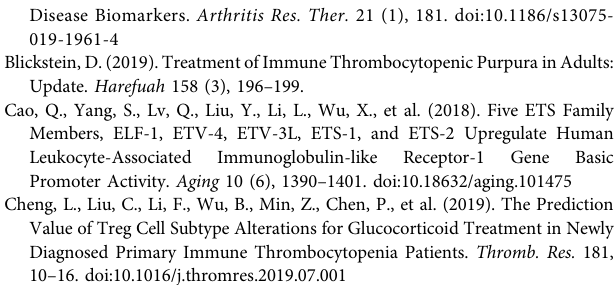
Supplementary Figure 1 | In fl uence of HUWE1 on Treg cell immunosuppressive function. CD4 + T cells in peripheral blood from ITP patients were transfected with HUWE1shRNAfor96 h;CD4 + Tcellsinperipheralbloodfromhealthycontrolswere transfected with Lenti-HUWE1 for 96 h (A,B) The CTLA-4 and LAG3 expressions were assessed using qRT-PCR (mean ± SEM, n (cid:2) 3). ** p < 0.01 vs. shRNA or Lenti. The experiment was repeated three times. Supplementary Figure 2 | Effect of BI8622 on the ubiquitination degradation of Ets-1 by HUWE1. Ubiquitin assay was performed to analyze the ubiquitination of Ets-1 afterthe BI8622 treatment. Theexperiment wasrepeatedthreetimes.DMSO: dimethyl